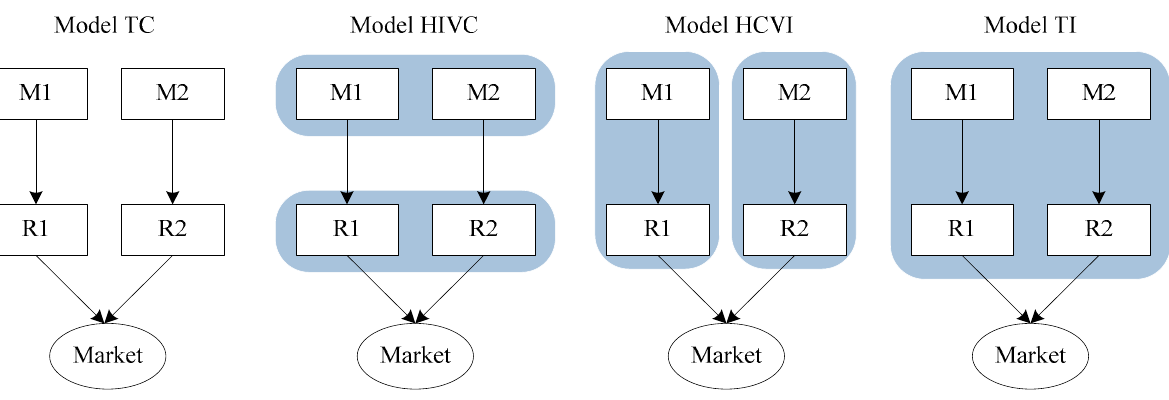
Figure 1. Four supply chain structures (M: Manufacturer, R: Retailer).